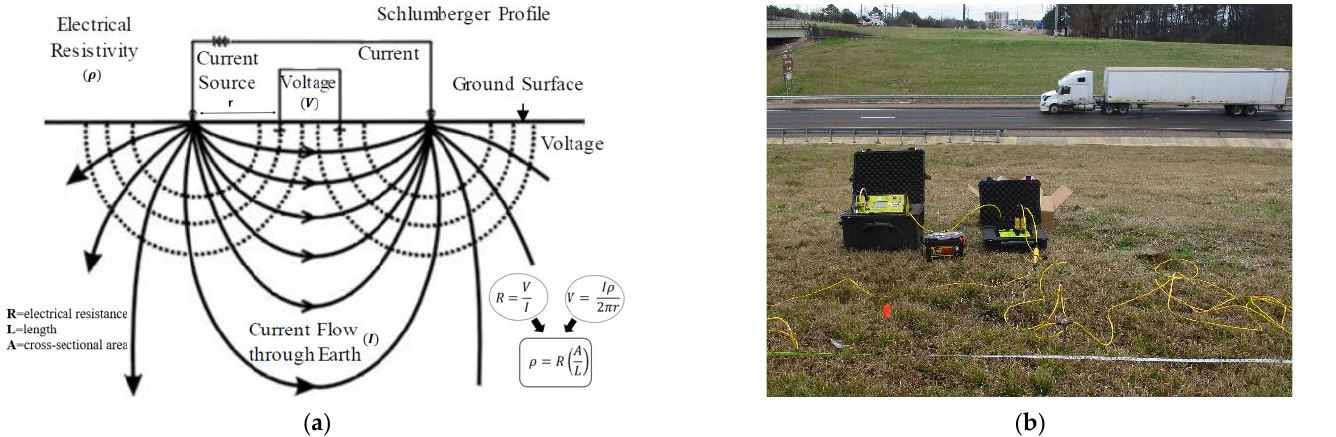
Figure 7. ( a ) ERI Subsoil current flow profile [25] ( b ) ERI equipment and field investigation.